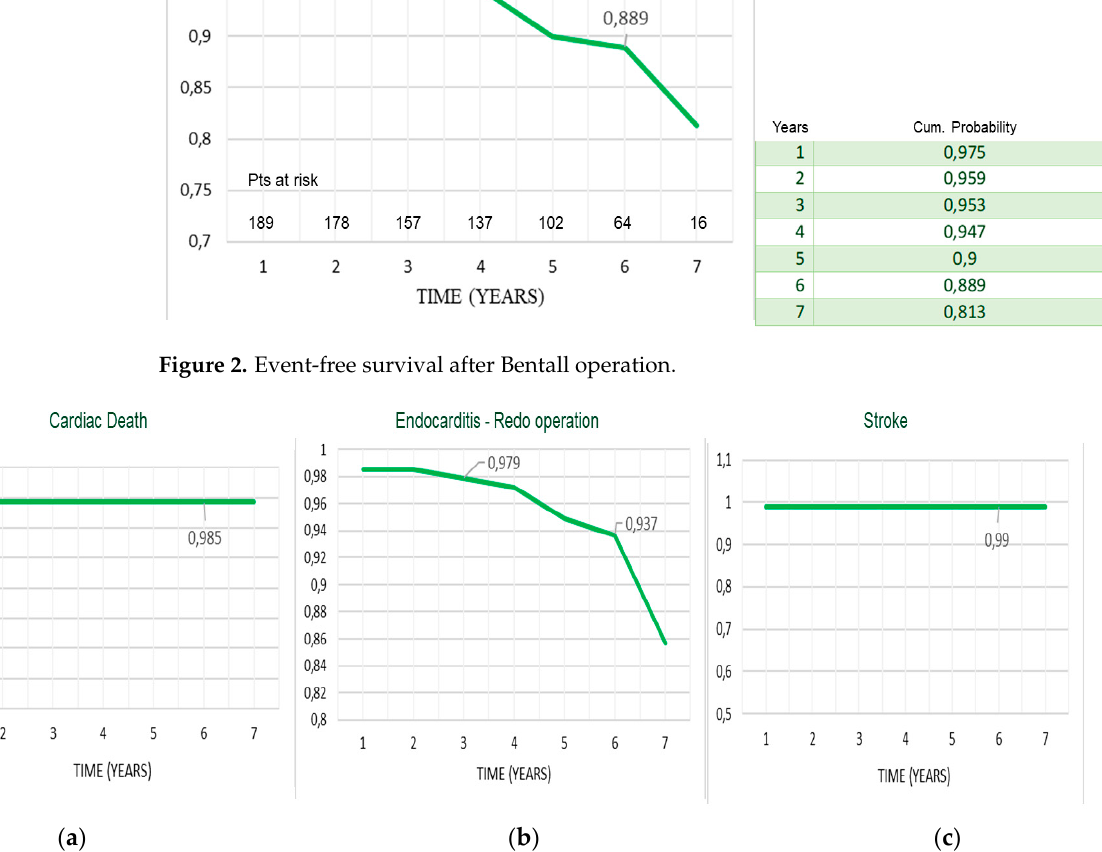
Figure 3. Freedom from late cardiac death ( a ); from endocarditis and redo operation ( b ); from stroke ( c ).